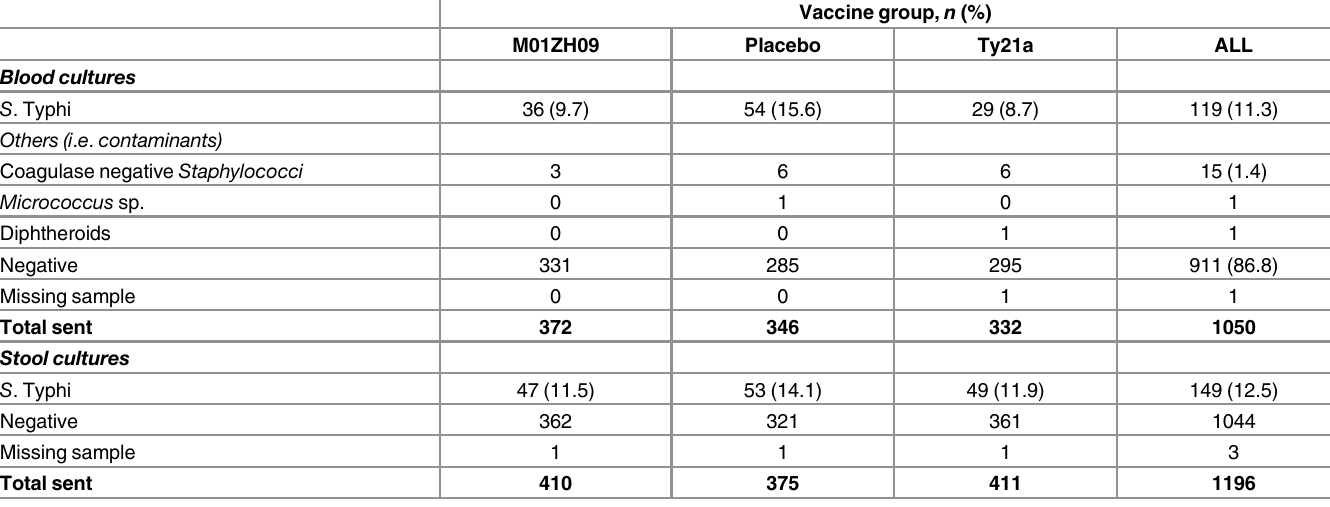
Table 3. Summary of microbiological results obtained over the entire study period (including stool clearance